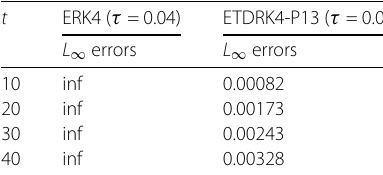
Table 5 Stability of the ERK4 method and the ETDRK4-P13